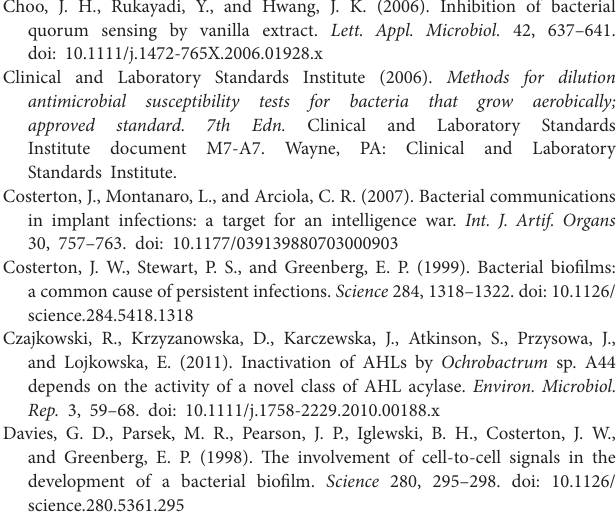
Supplementary Figure S1 | (A) Assessment of QQ activity of MSB-28 using C. violaceum 12472 by soft agar overlay assay. (B) Quantitative assessment of violacein inhibition in CV026 by CFS of MSB-28 at increasing concentrations. Mean values represent the data of three independent experiments and SD are shown. Supplementary Figure S2 | Detection of AHL produced by Psychrobacter sp. via the biosensor CV026. (a) Natural C 6 -HSL as positive control, and (b) extract from the spent culture supernatant of Psychrobacter